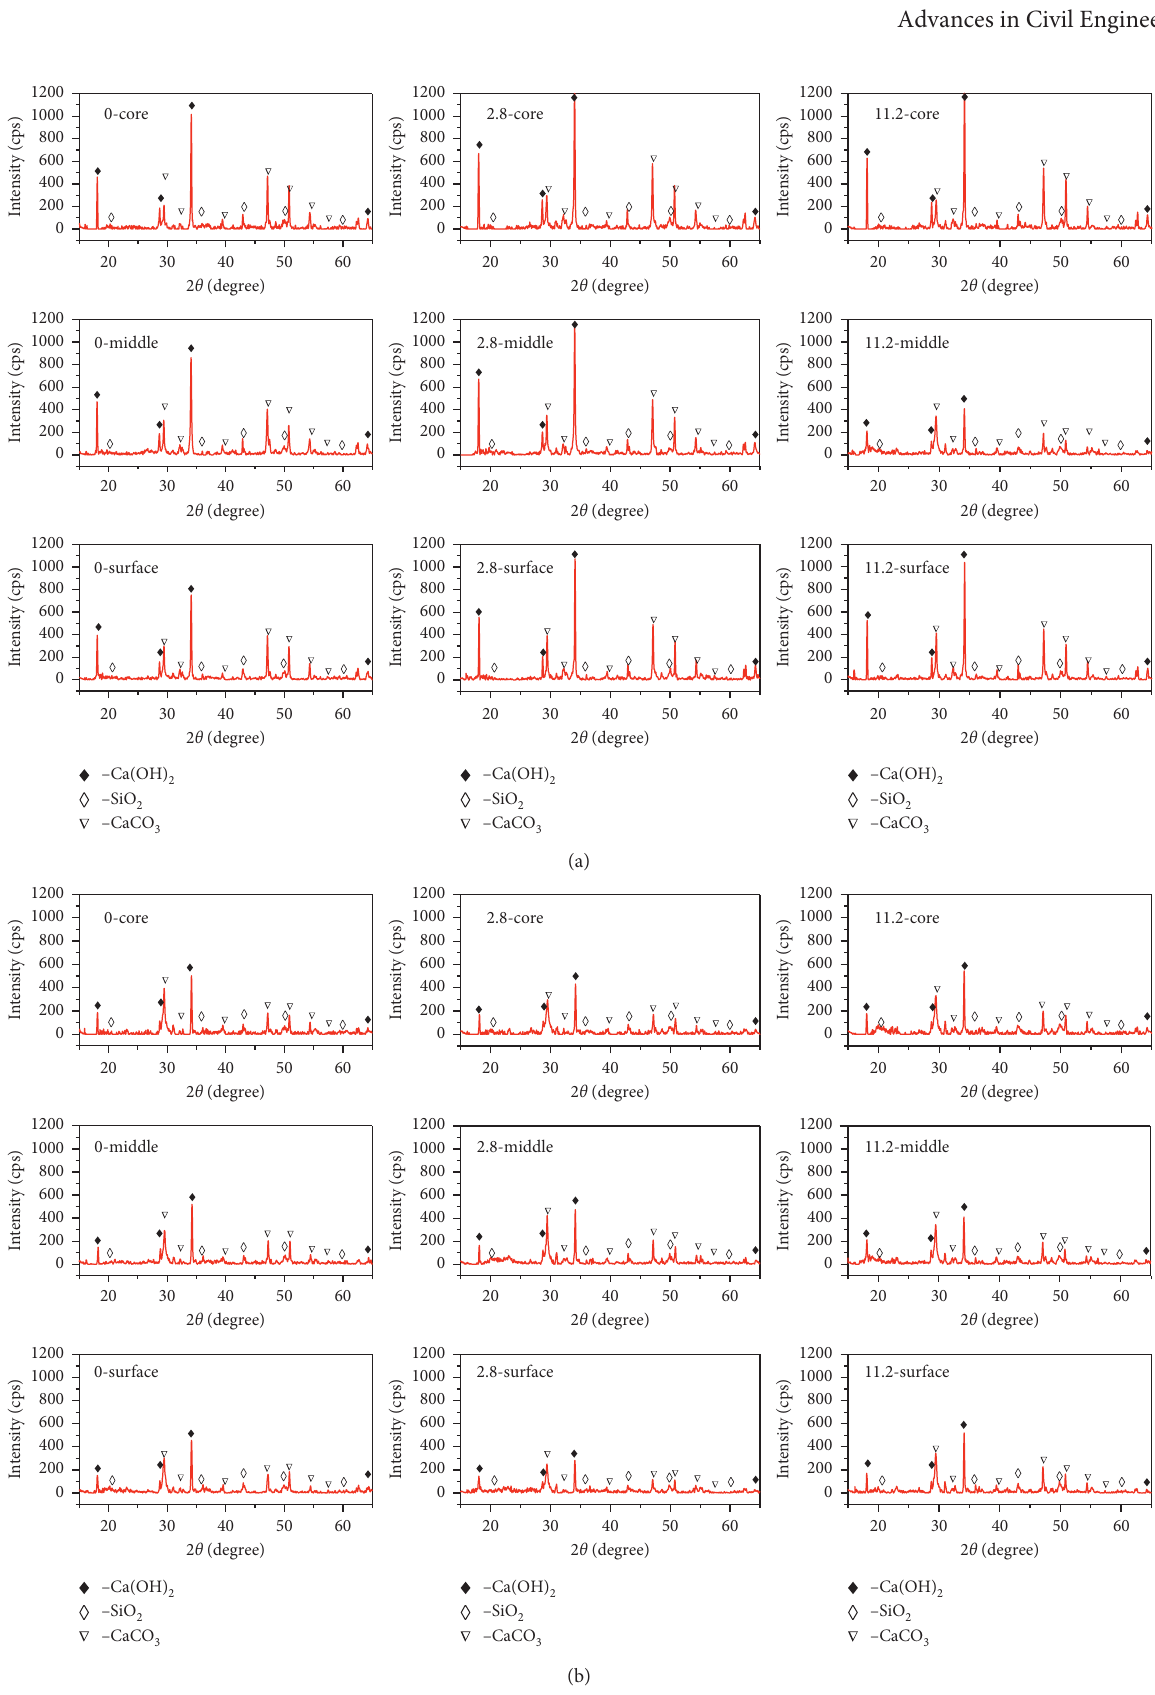
Figure 7: XRD at different sampling depths for 56d. 0, 2.8, and 11.2 represent the flow velocity, respectively. (a) OPC; (b)